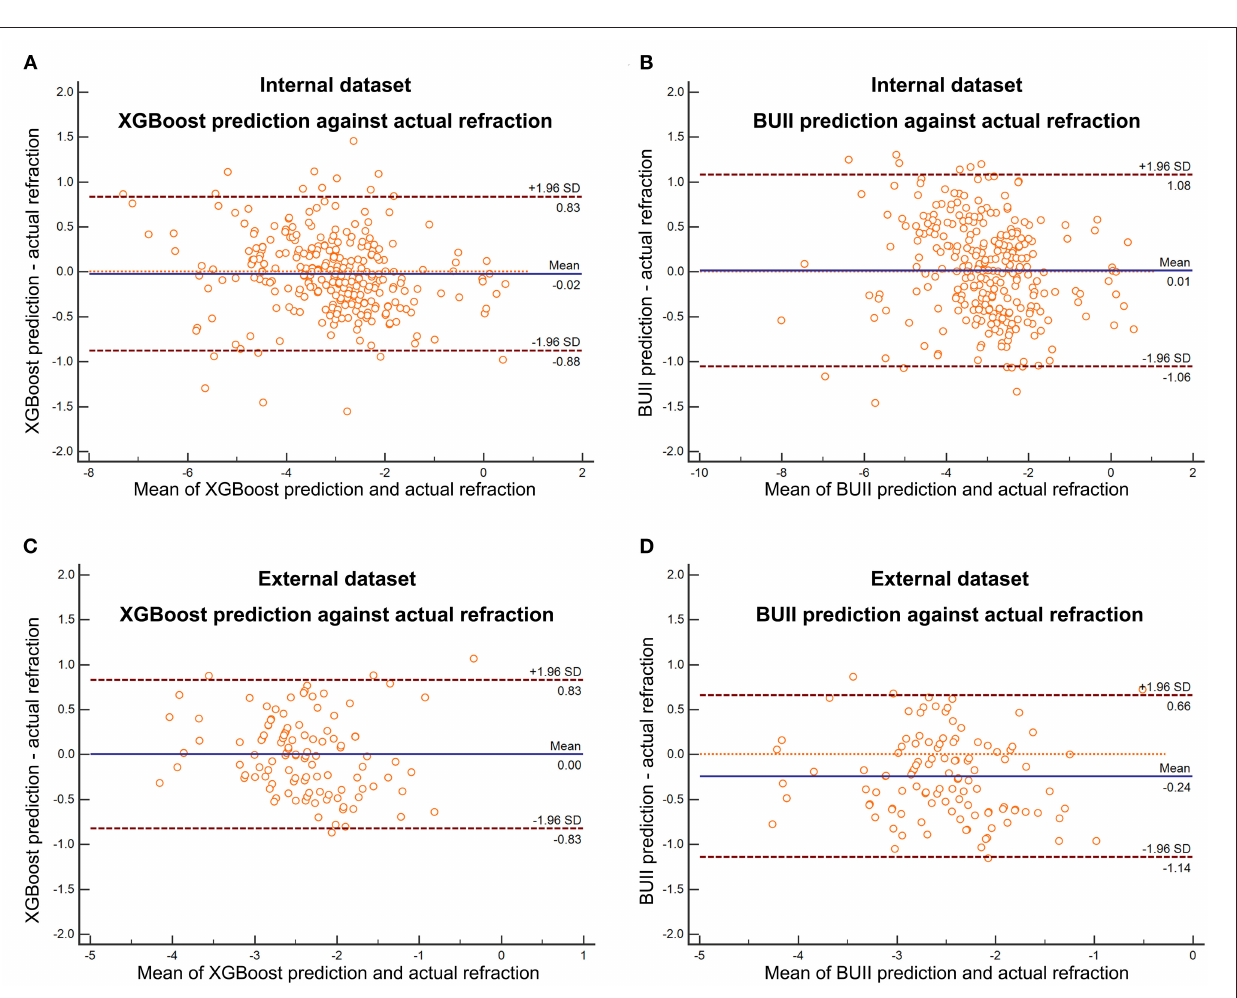
Frontiers in Medicine |